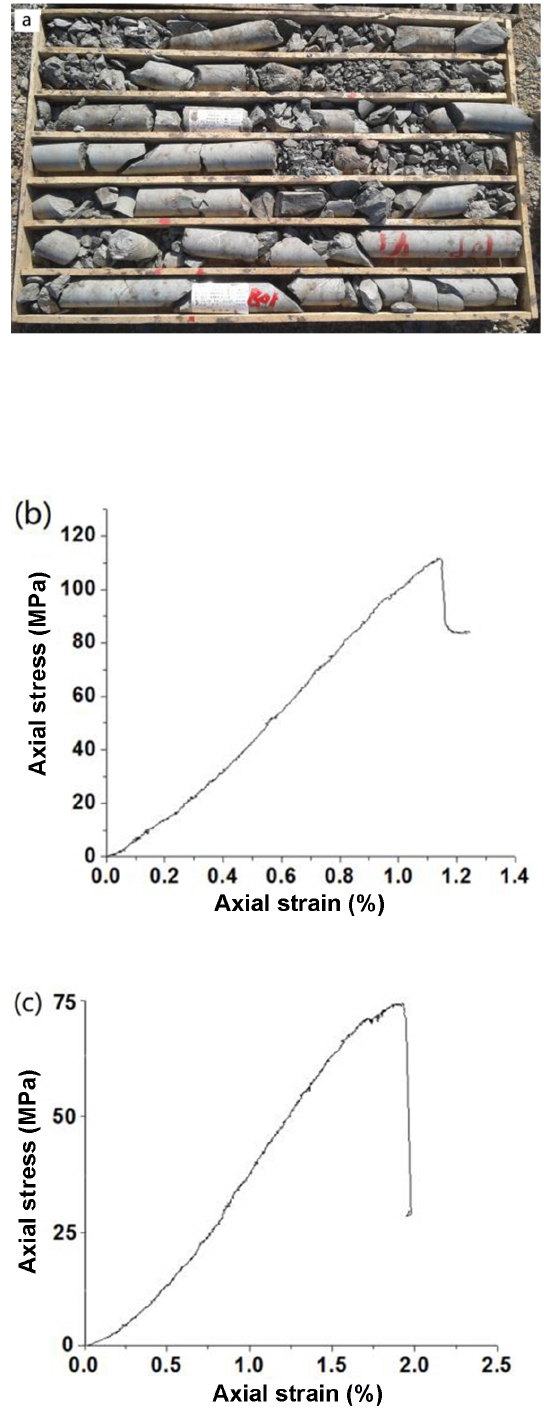
Figure 9. Triaxial compression tests for determining the geome- chanical parameters of the two mica-quartz schist. (a) Samples for the experimental tests. Typical stress–strain relations under a con- fining stress of 20MPa are shown for (b) the samples with a degree of saturation of 43% and (c) the samples in a saturated state, re- spectively.